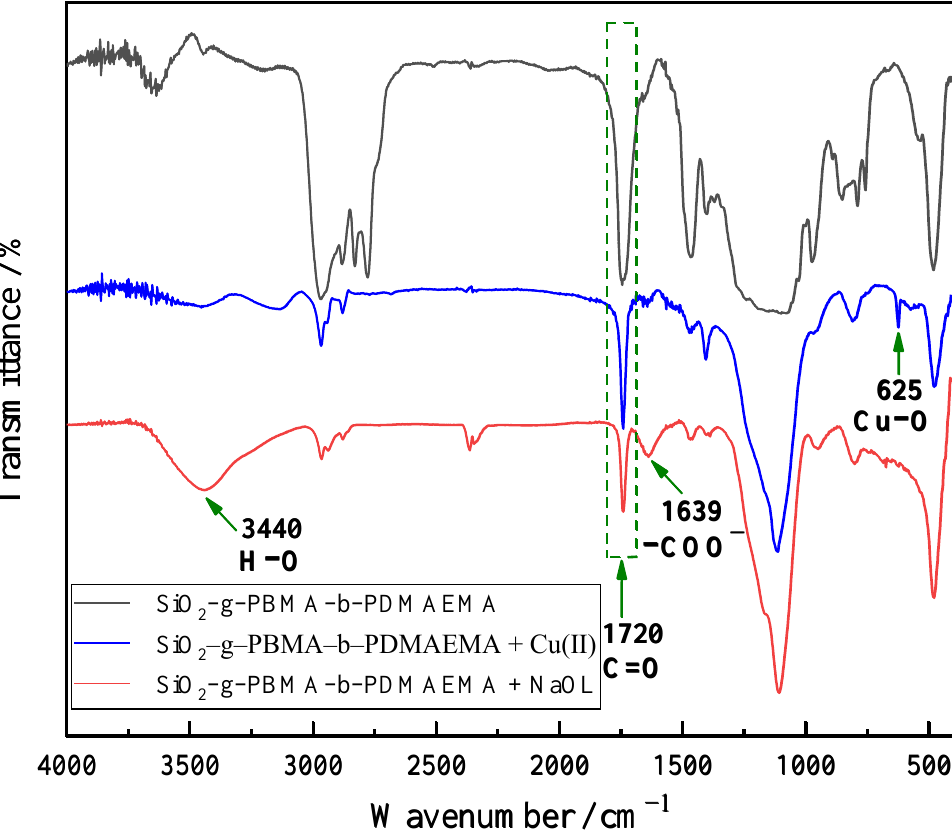
Figure 6. FTIR spectra of complexes of SiO 2 –g–PBMA–b–PDMAEMA with Cu( II ) and NaOL.